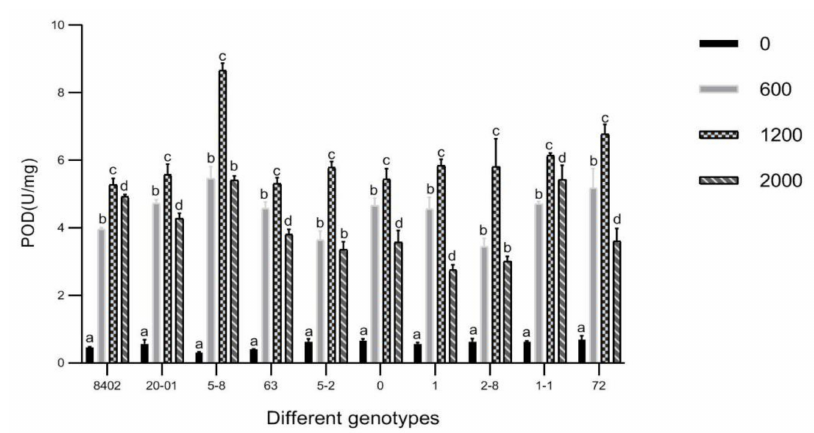
Figure 16. Catalase (CAT) activity in leaves of C. bungei .